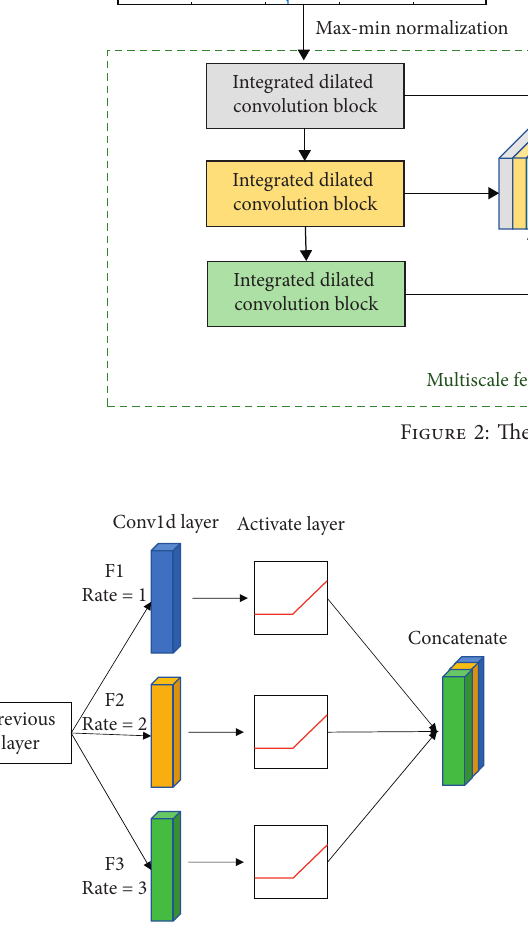
Figure 3: The integrated dilated convolution